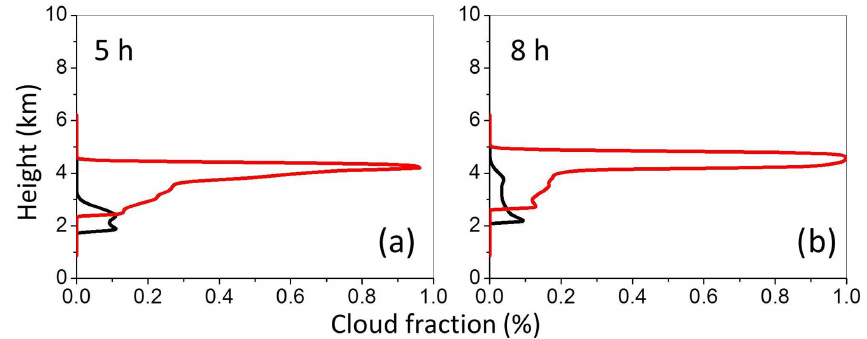
Figure 11. Cloud fraction profiles at (a) hour 5 and (b) hour 8 from dry and wet simulations of the IGOC field project. Red/black lines are for the dry/wet